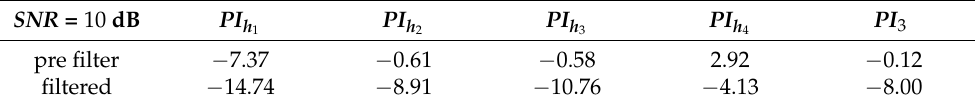
Table 2. Values [dB] of the performance indexes defined by (12): case of SNR = 10